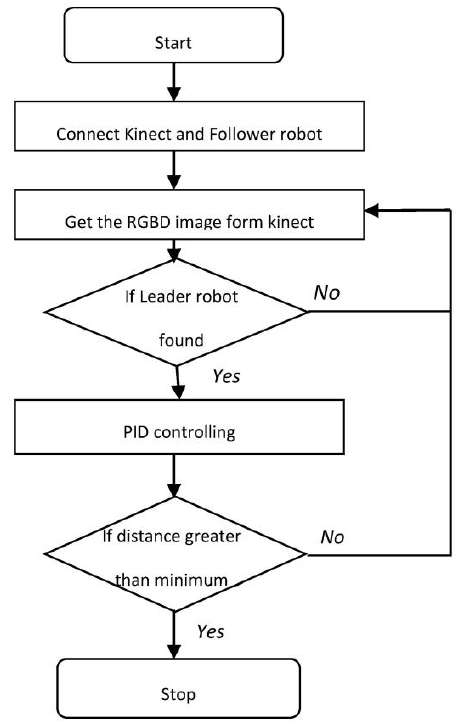
Figure 2. Motion of the follower robot.